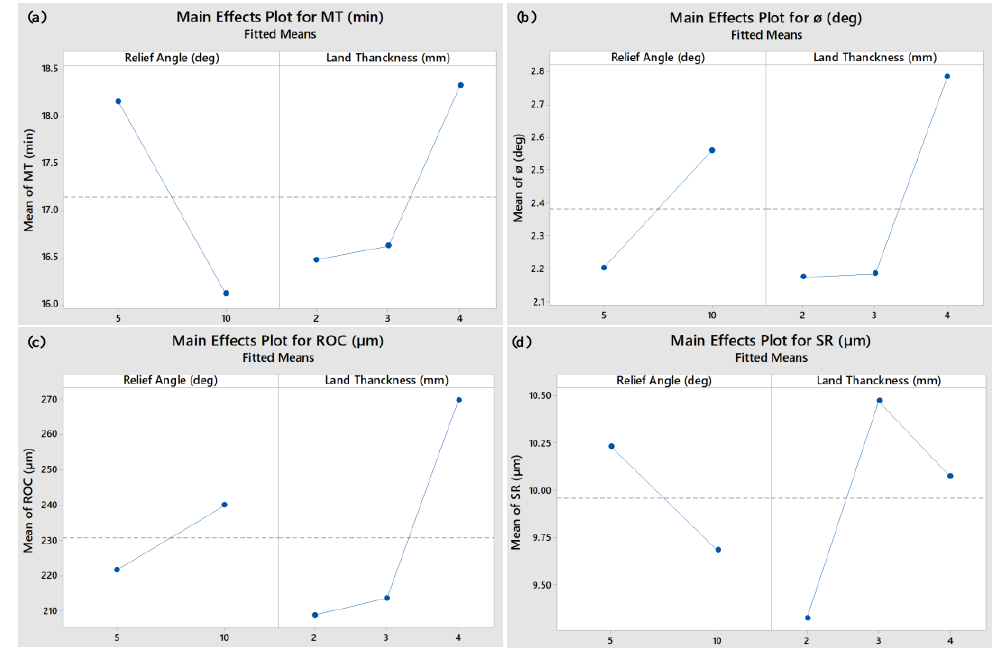
Figure 8. Main effects plots of machining performance measures; ( a ) machining time (MT), ( b ) taper angle (ø), ( c ) radial overcut (ROC), and ( d ) surface roughness (SR).